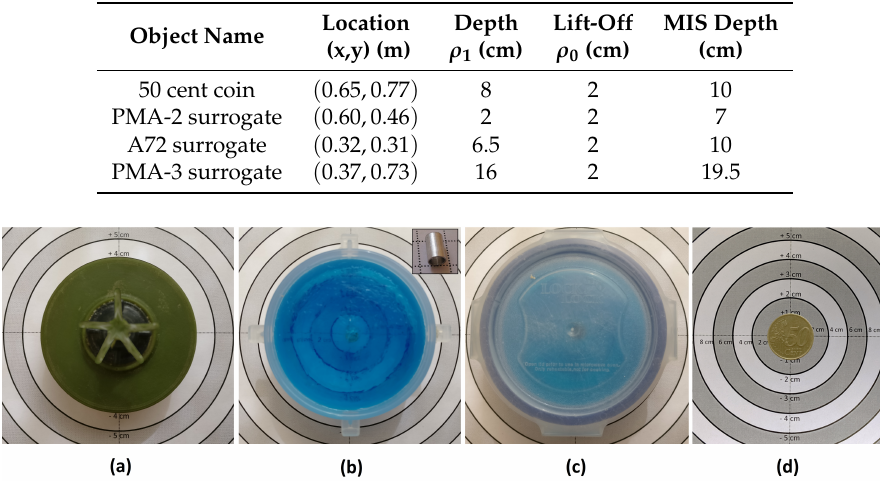
Figure 9. Test objects used: ( a ) PMA-2 surrogate; ( b ) type A72 surrogate—lid removed with metallic